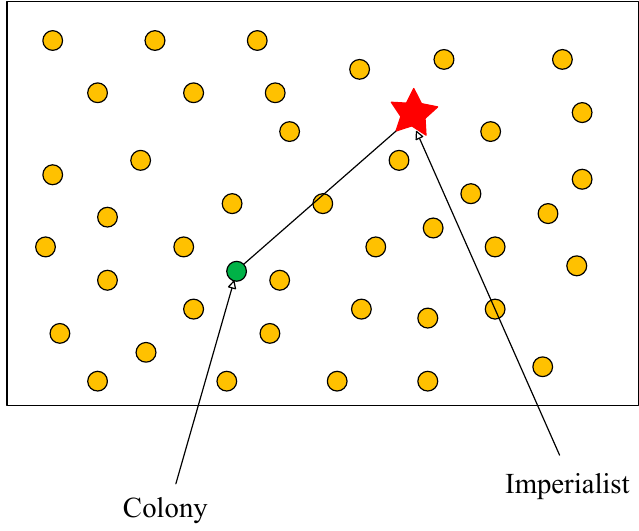
Figure 4. The initial empires generation [82].